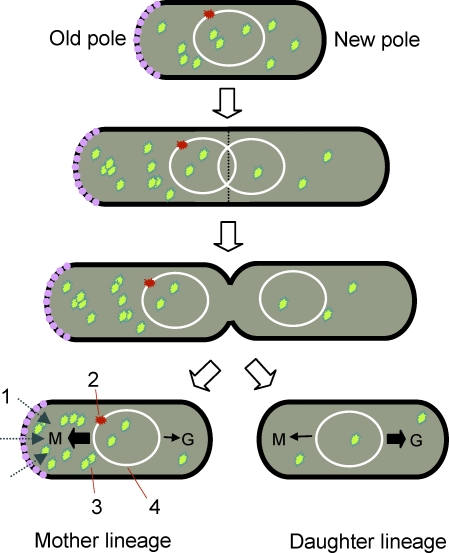
Schematic Representation of Possible Aging Factors in a System Dividing by Binary FissionDuring cytokinesis, one daughter cell will inherit a pole that is older than the one inherited by its sibling. Intriguingly, the “old pole” cells of E. coli display a progressive increase in their generation time [5]. There are several potential reasons for this decline in physiological fitness: (1) Inheritance of older cell-surface material may reduce the ability of the cell to insulate itself against the environment. (2) Segregation of differently damaged, and potentially cytotoxic, DNA strands [15] could provide one daughter with a noncorrupt message akin to the “immortal DNA strand” cosegregation mechanism originally proposed by Cairns for preserving the integrity of stem cell genomes [27]. (3) Segregation of cytotoxic molecules, such as extragenomic episomes or oxidatively damaged and aggregated proteins, may result in sibling-specific deterioration. (4) Segregation of damage could cause a reduction in fitness even in the absence of cytotoxicity, since the sibling inheriting more damage may, as a consequence, upregulate maintenance (M) (damage defense) systems. In view of the fact that the transcriptional power of cells like E. coli is limiting, such an elevation of maintenance activities could be traded for a reduction of growth-related activities (G) [28,29].